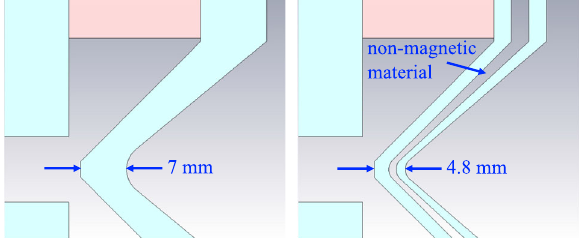
FIG. 16. Comparison between single- and double-septum structures. (Left) Original shape with the thickness of 7 mm at the median plane. (Right) Double layer of the iron with non- magnetic gap between them. The thickness is reduced by 2.2 mm compared to the original